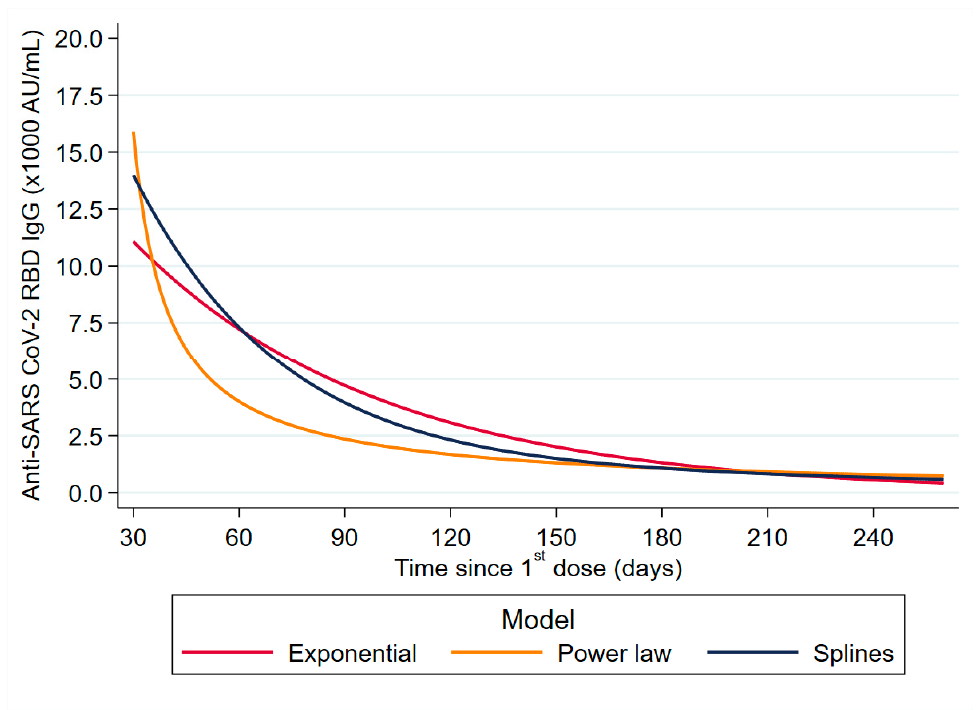
Figure 1. Comparison of three models (splines, exponential, and power-law) for the predicted trajectories of anti-SARS-CoV-2 RBD IgG antibody levels over time. According to RCSM, the day where antibody levels reached 50% reduction from the peak levels of the 30th day was day 62 (95% CI 59.9–64.5), while in EM and PLM, this was